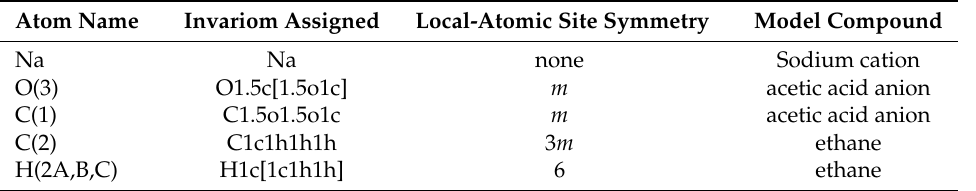
Table 2. Details of invariom refinement